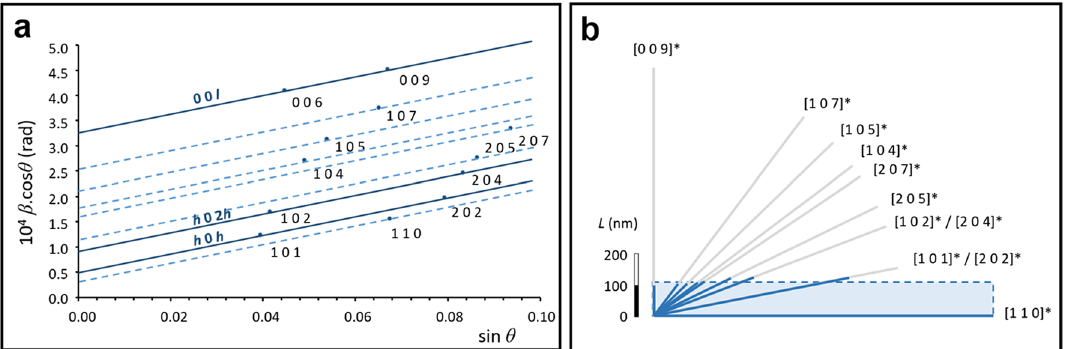
Figure 3. ( a ) Williamson-Hall (WH) analysis for HC of the α fragment. The h 0 h, h 0 2 h and 0 0 l lines exhibit a similar slope that was applied to the other reflections for the determination of the size broadening. ( b ) ( a* , c* ) cross section (shaded area) of a typical HC platelet of the α fragment, based on crystal dimensions computed by Williamson–Hall ( hkl ) planes, and ε the strain coefficient, the broadening of diffraction peaks are given by the Williamson & Hall’s (WH) linearized form 17 :